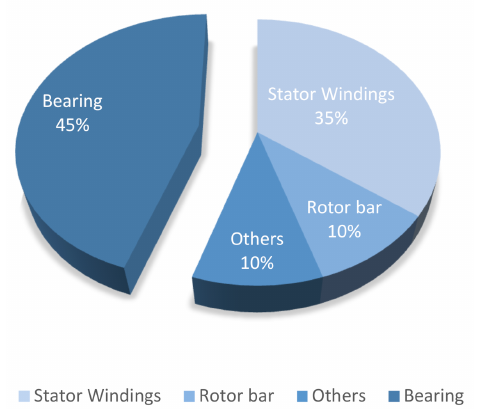
Figure 1. Electric motor fault